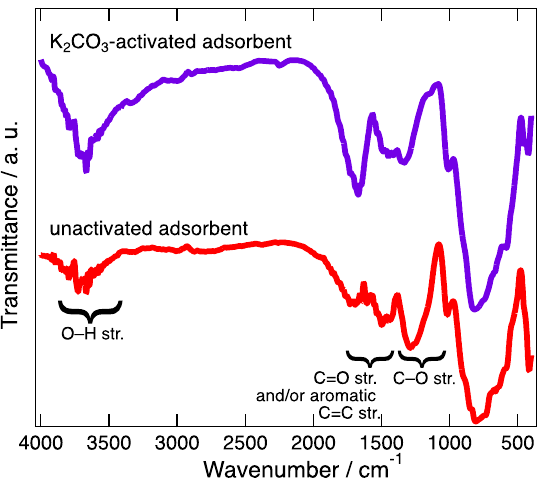
Figure 4. FT-IR spectra of unactivated adsorbent (red) and K 2 CO 3 -activated adsorbent (purple).